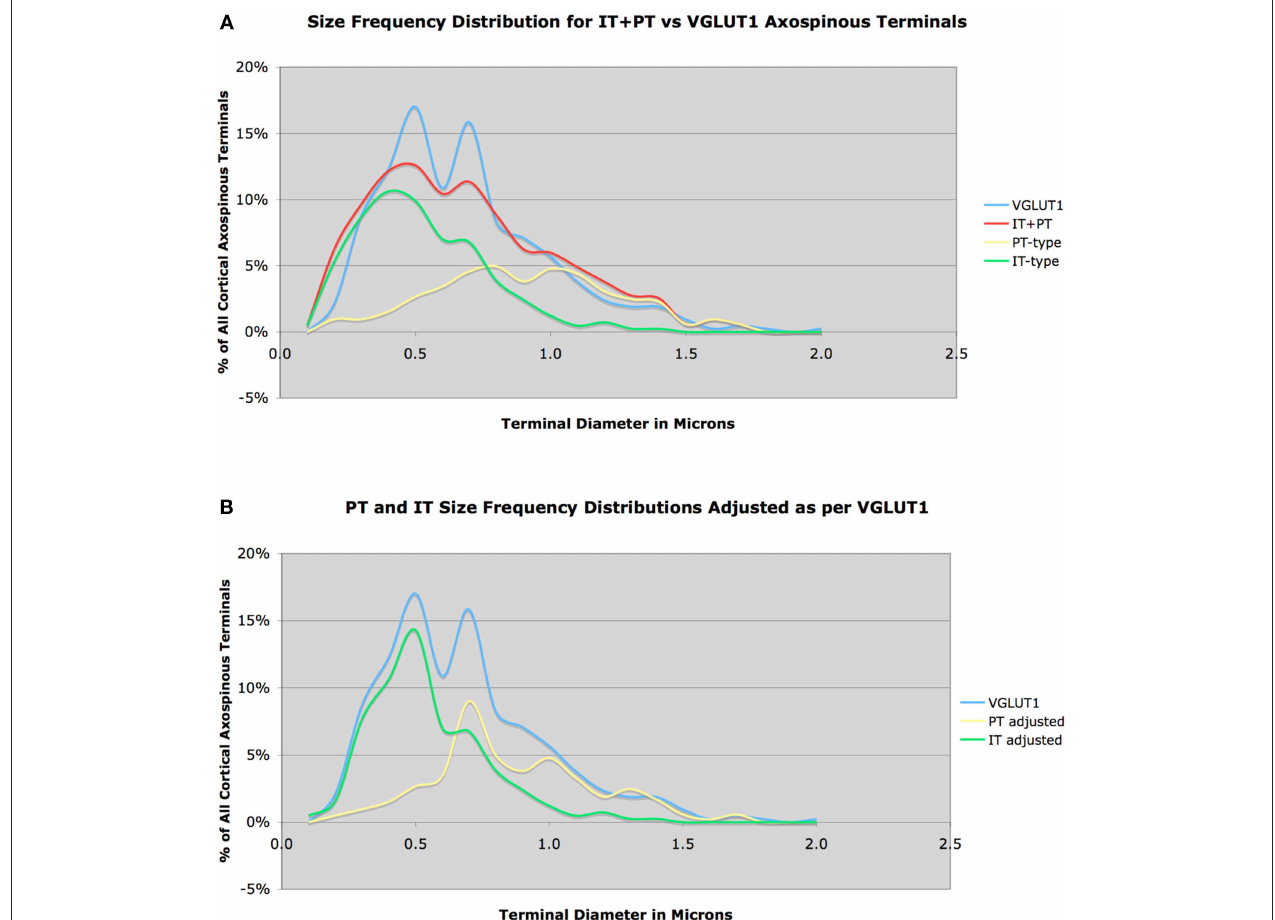
to closely approximate the VGLUT1 distribution, but there is a short fall in IT-type and PT-type terminals at 0.5 and 0.7 μm, respectively. In image (B) , we have corrected for this shortfall, by adjusting the IT-type and PT-type distributions slightly to fit the VGLUT1 distribution, again with the IT-terminals graphed as 58% and the PT-type 42% of all corticostriatal axospinous